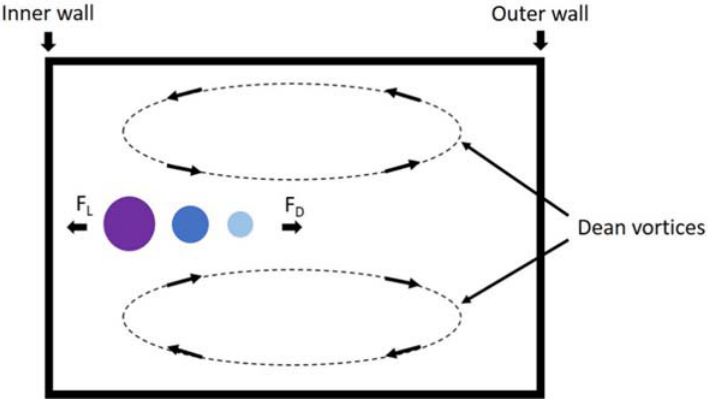
Figure 1. The schematic cross section of a curved microchannel, illustrating the focusing positions of particles of varied size. The lift force and the Dean drag force are highlighted. (Redrawn from ref [28]). Another parameter that must be considered is ratio denotes the particle diameter and ν is the smallest channel dimension. This ratio for particles to be focused [1,21,28].